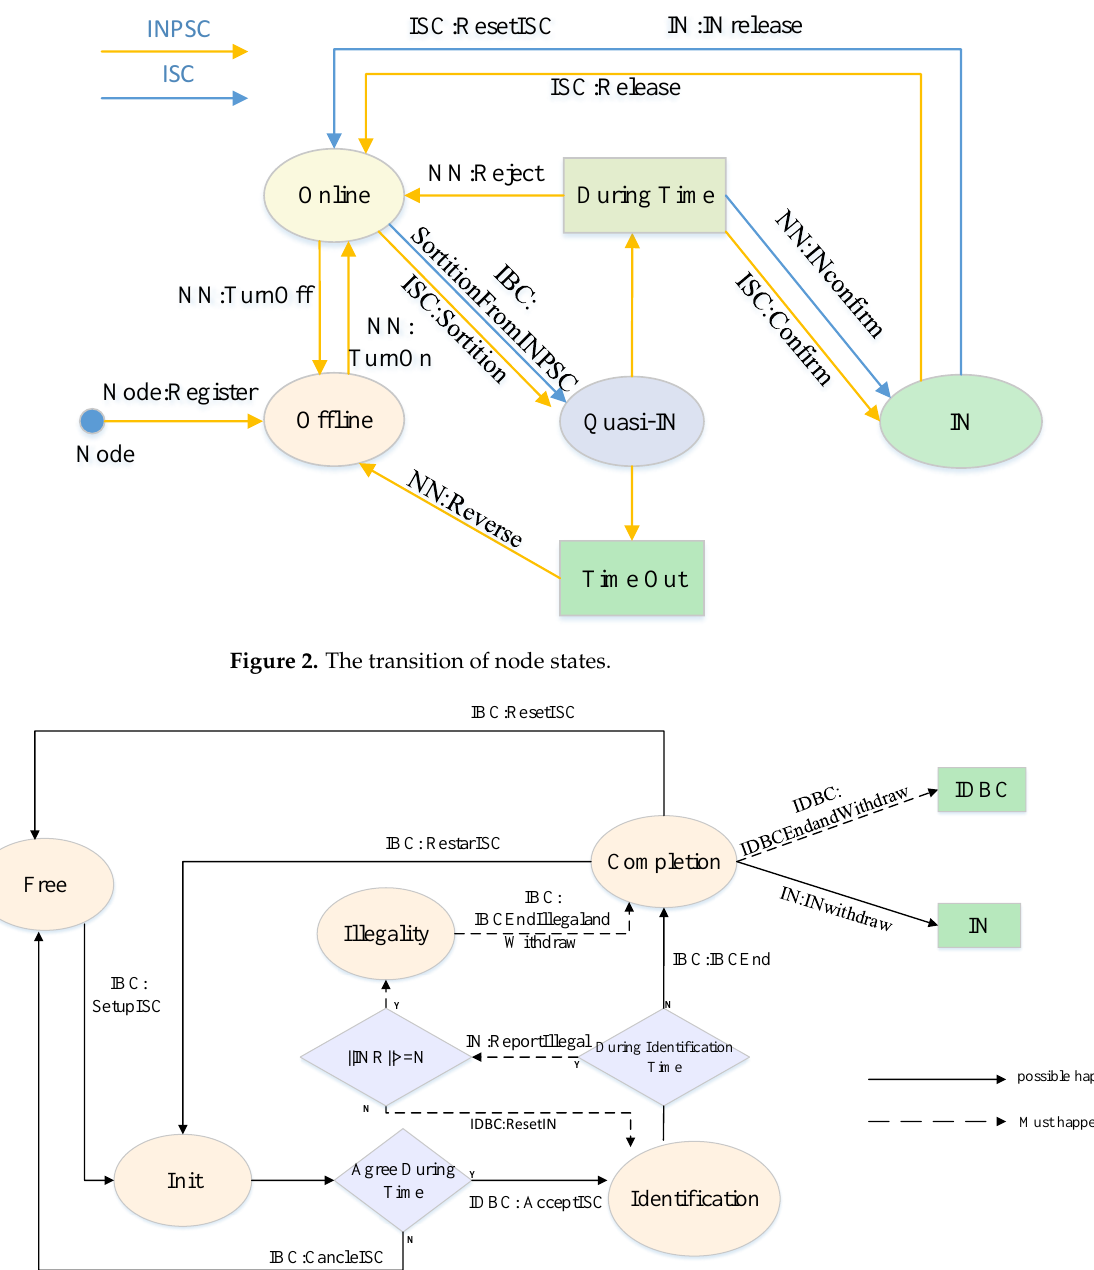
Figure 3. The transition of identification states.